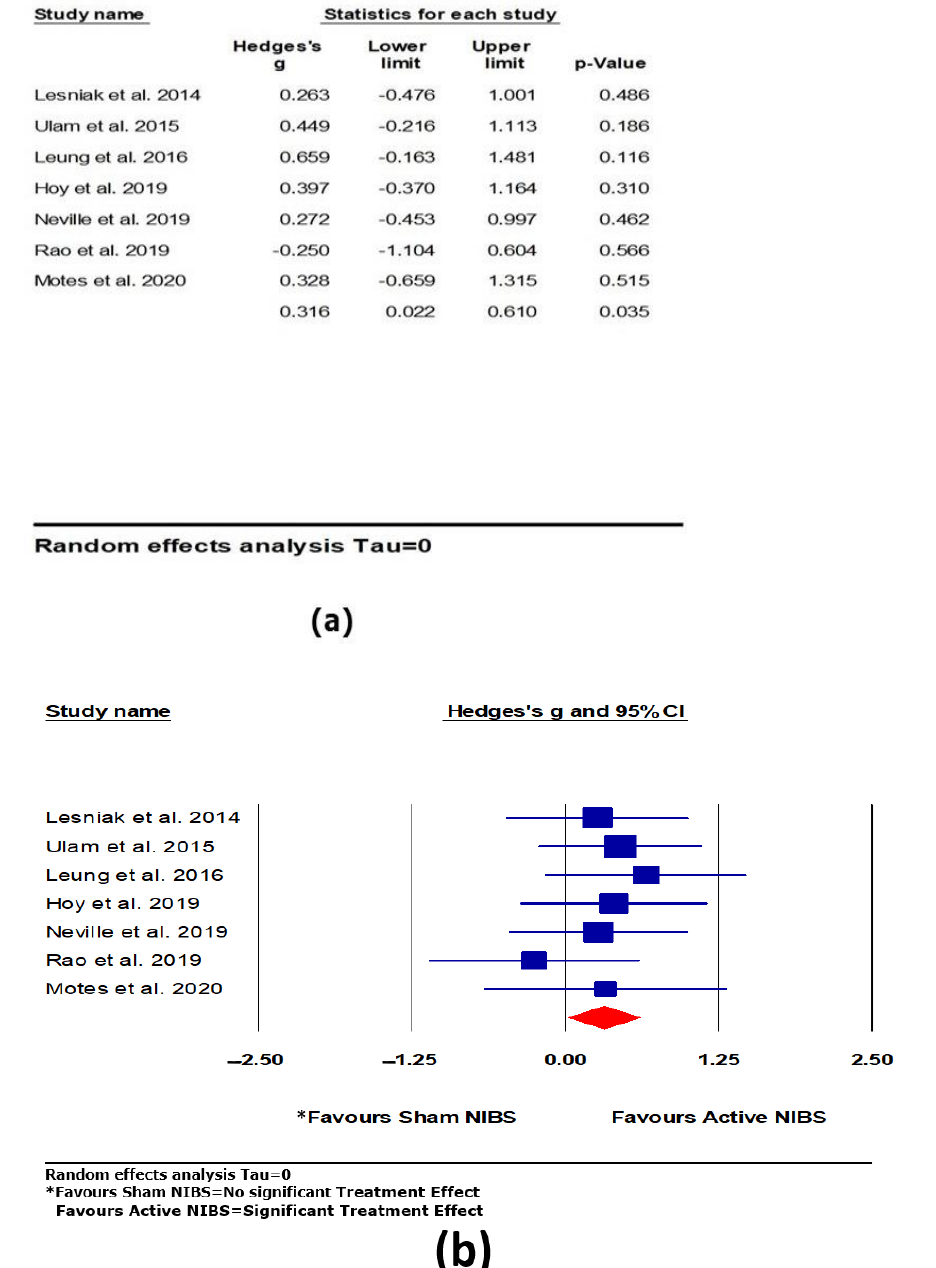
Figure 4. The effect of non-invasive brain stimulation (NIBS) on attention; ( a ) summary Table for each study; ( b ) forest plot for each study [38,55–59,61].